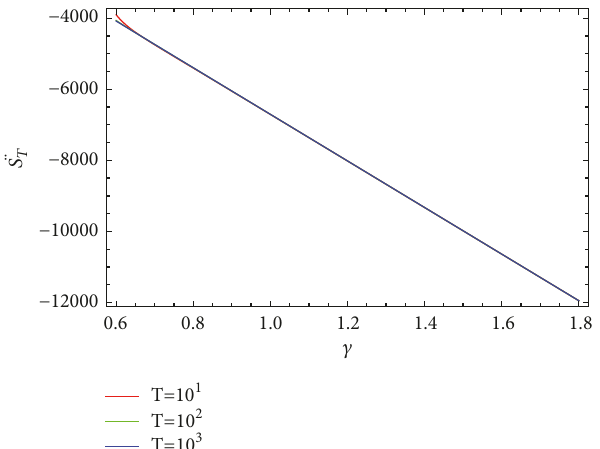
̈𝑆 𝛾 for logarithmic corrected entropy when Γ is a Figure 6: Plot of 𝑇 versus